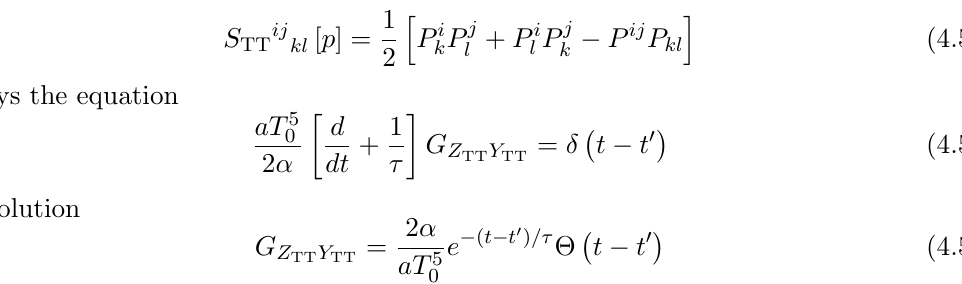
Table 1 . Summary of vector causal propagators. ! and ’ p are de(cid:12)ned in eq. (4.45).